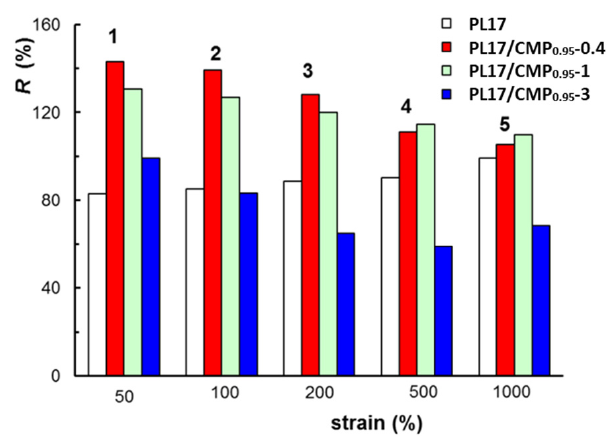
Figure 13. The degree of structural recovery after applying step strains cycles.